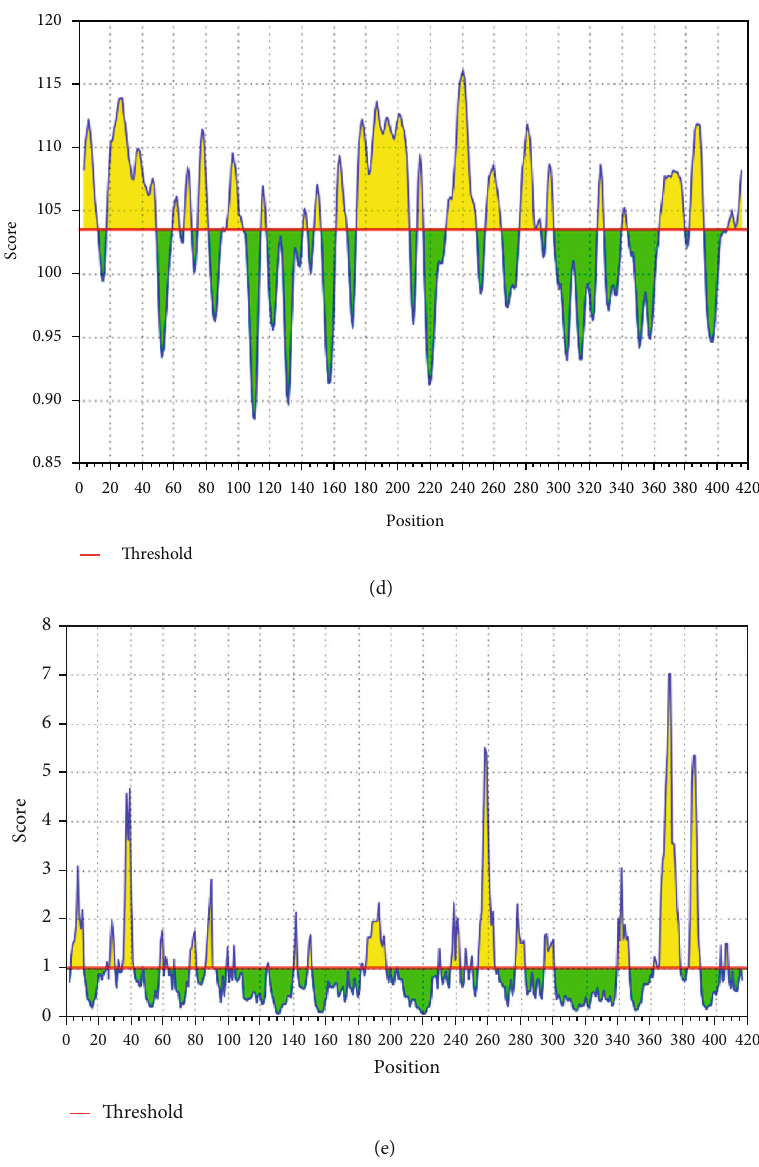
Figure 3: (a – f) The properties of the B cell linear epitope predictions: (a) the linear epitopes, (b) hydrophobicity, (c) antigenicity, (d) fl exibility, and (e) surface accessibility. Green regions under the threshold color denote unfavorableness related to the properties of interest. Yellow colors are above the threshold sharing higher scores. Horizontal red lines represent the